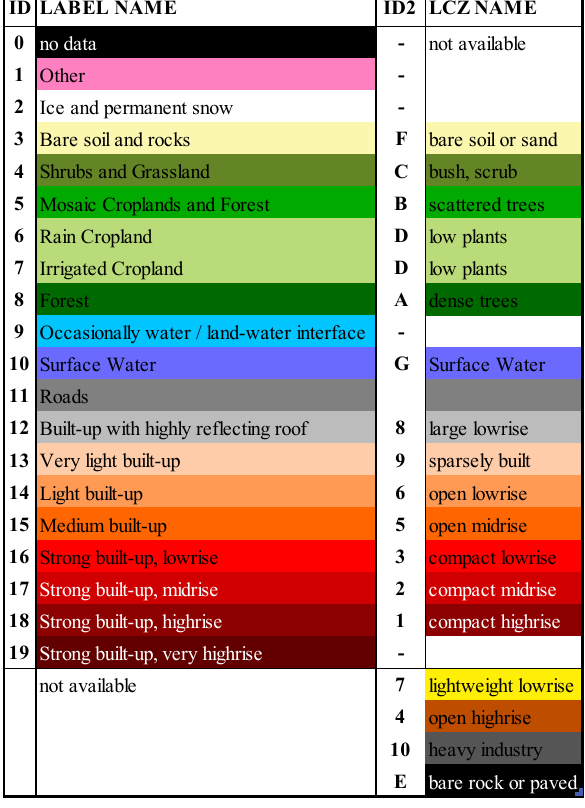
Table 3. Common colour code for LABEL and